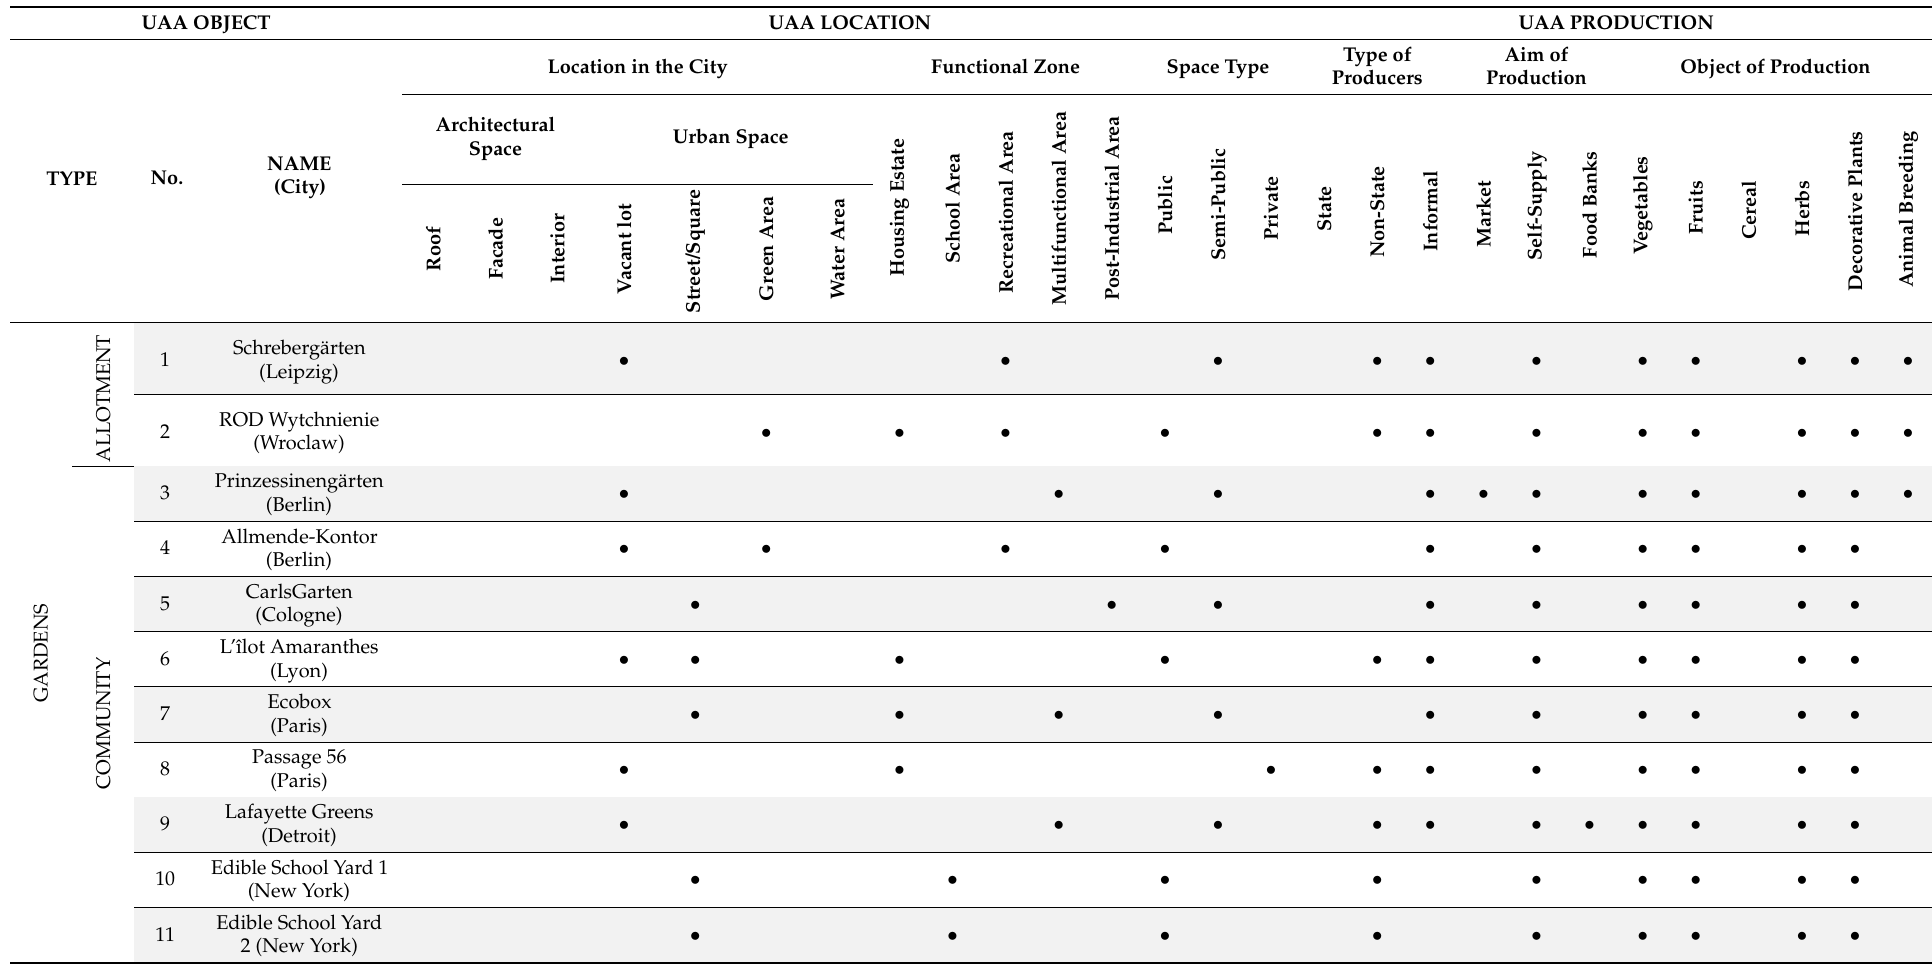
Table 1. List of 25 compared UAA projects—the bullets indicate the features of the object in question. (compiled by A.